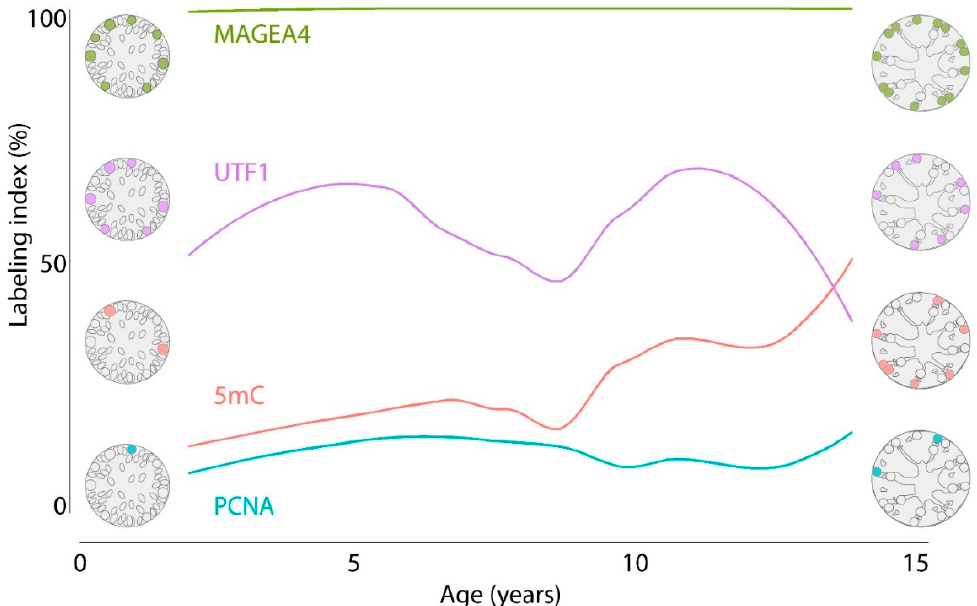
Figure 3. Schematic representation of the dynamic spermatogonial labeling index (%) in testicular tubular cross-sections during normal testicular development. Expression patterns of MAGEA4 (green), UTF1 (purple), 5mC (pink), and PCNA (blue) are the result of smooth interpolation of the data.